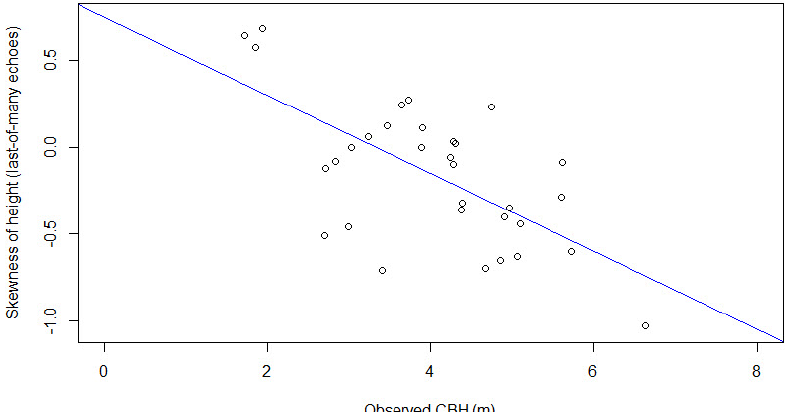
Figure 8. A scatterplot of the skewness of height for the last-of-many echoes vs. the field measured CBH values ( R 2 =